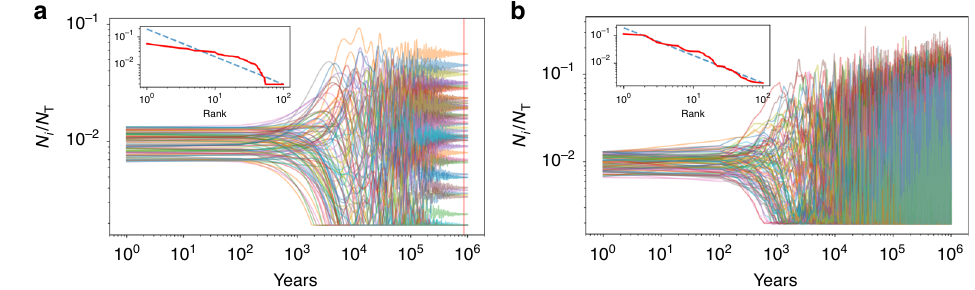
Fig. 2 City size distribution emerging from stochastic demographic dynamics differ signi fi cantly from those in time independent environments. a depicts the temporal trajectory for a set of 100 cities in a non-stochastic, non-linear environment, described by Eq. (8). Despite generalizing the demographic dynamics in Fig. 1, this results in a fi xed urban hierarchy at late times (vertical red line), regardless of initial conditions. However, when migration and vital rates become stochastic, the demographic dynamics no longer has a static solution at long times, b . Instead, cities constantly change their relative sizes (rank) over time. After an initial transient, the population structure fl uctuates close to Zipf's law. The insets show the population structure (red) at the point in time when the non-stochastic evolution ( a ) becomes approximately stationary, with Zipf's law (dashed blue line) shown for reference.